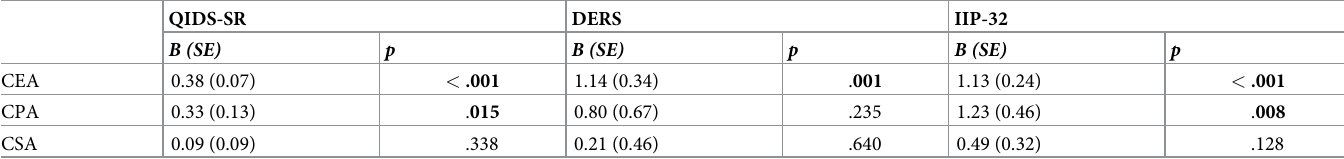
Table 4. Results of univariate linear regression analyses for predicting depressive symptoms, emotion dysregulation, and interpersonal problems in female college students ( N = 276). QIDS-SR DERS